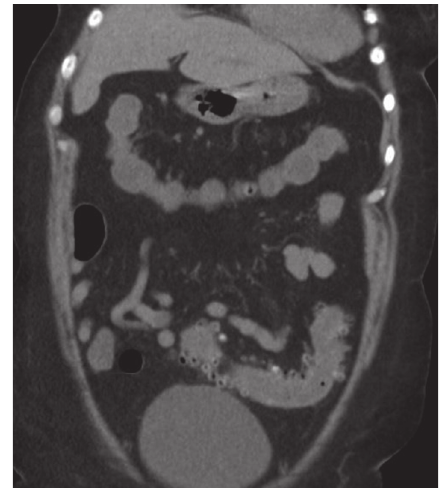
Figure 2: CT abdomen and pelvis without contrast, showing mild inflammation surrounding the sigmoid colon. Diverticulosis is